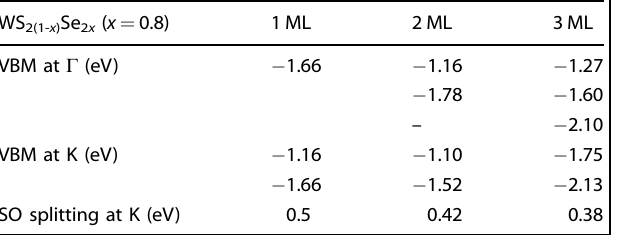
which was con fi rmed experimentally by ARPES and theoretically